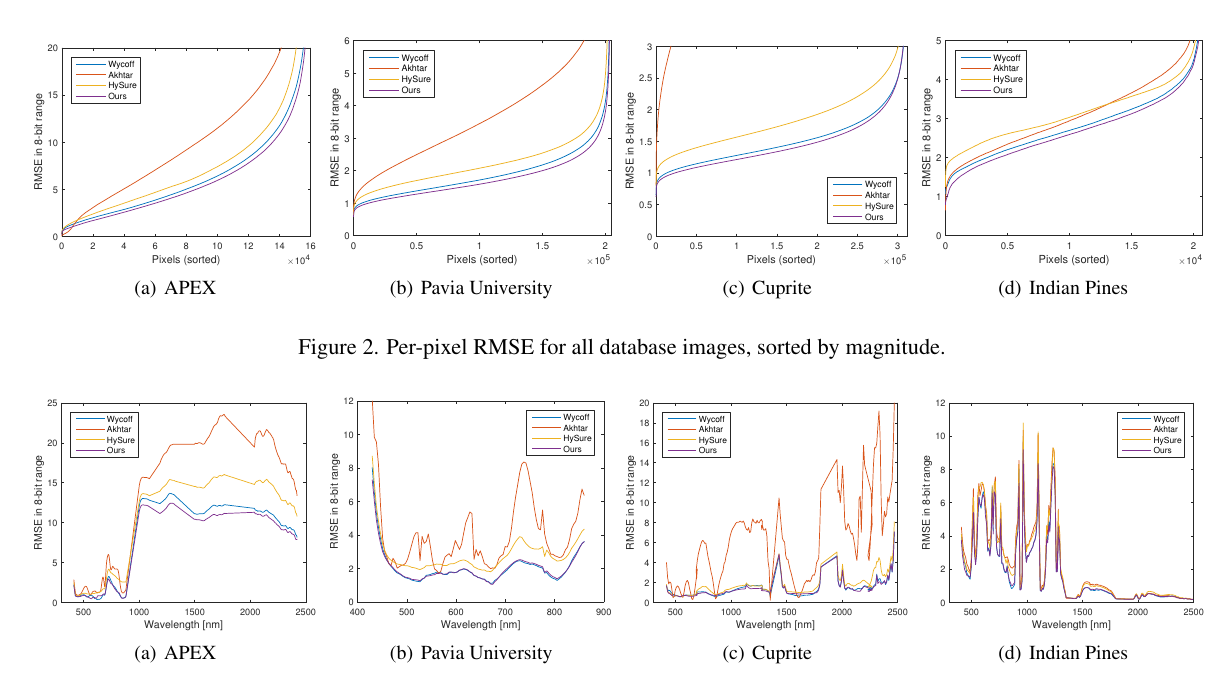
Figure 3. Per-band RMSE for every spectral